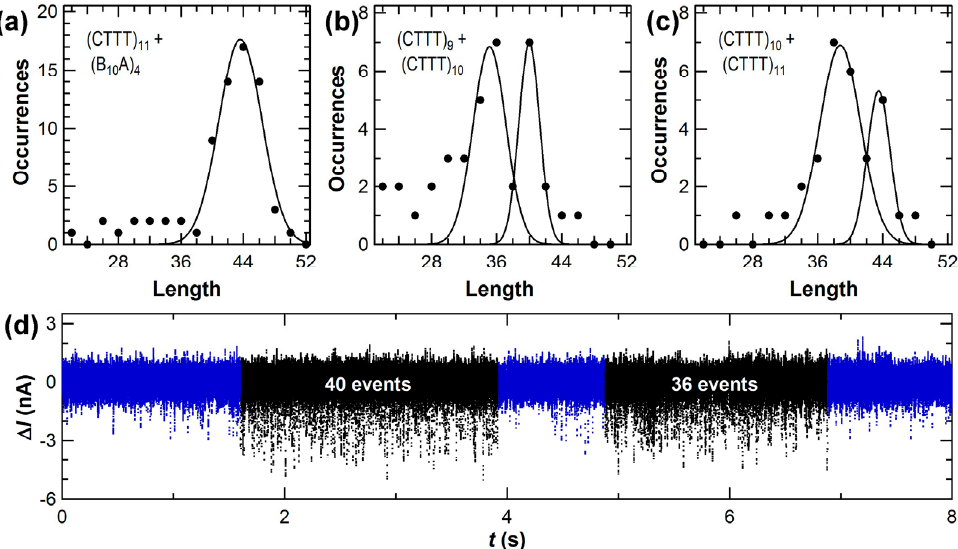
Figure 7. Base-enumeration distributions obtained from 0.5 nM concentrations of the templates: ( a ) (CTTT) 11 and (B 10 A) 4 measured separately; ( b ) (CTTT) 9 mixed with (CTTT) 10 ; and ( c ) (CTTT) 10 summarized in Table 2. Mixing two templates together led to fewer that 25 template molecules being counted in a typical data record, but the accuracy of peak fitting was not substantially reduced.